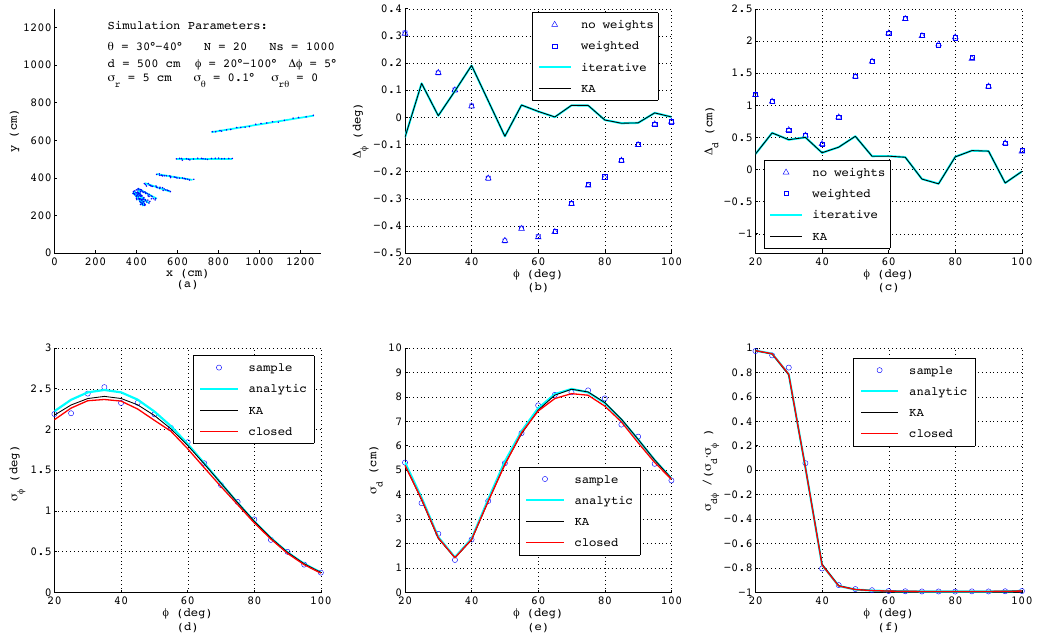
Figure 8. Results from simulated range-bearing scans of short lines superimposing low noise in the r - and θ